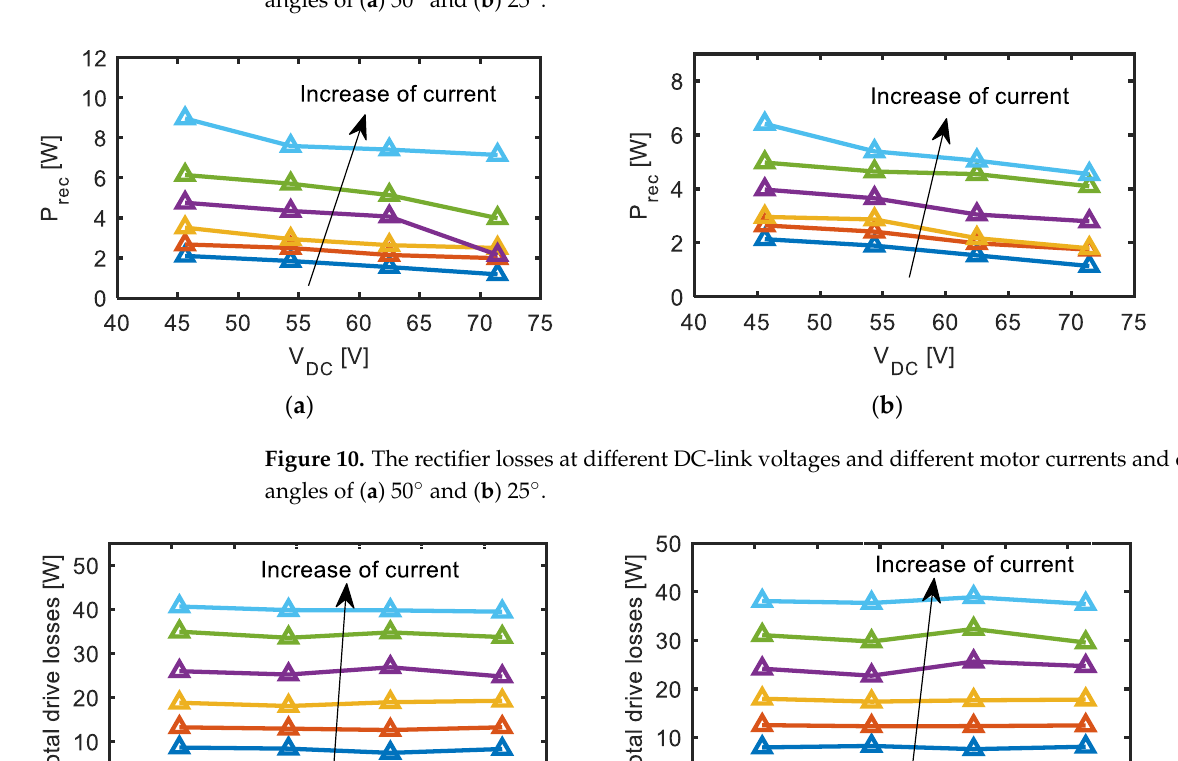
Figure 9. The DC-link current at different DC-link voltages and different motor currents and current angles of ( a ) 50° and ( b ) 25°.